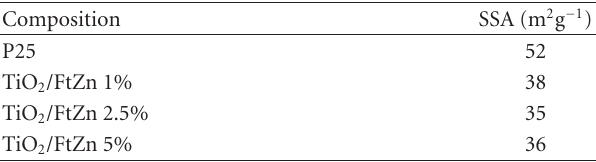
Table 2: Specific surface area values for TiO 2 and TiO 2 /ZnPc composites at di ff erent m/m ratios.